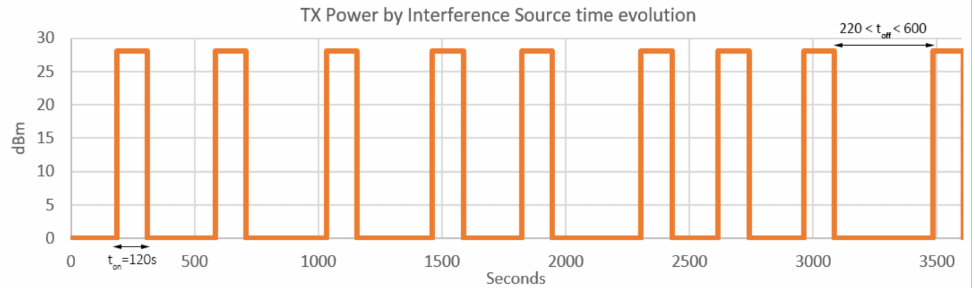
Figure 6. Signal transmitted by interference sources during saturation tests.